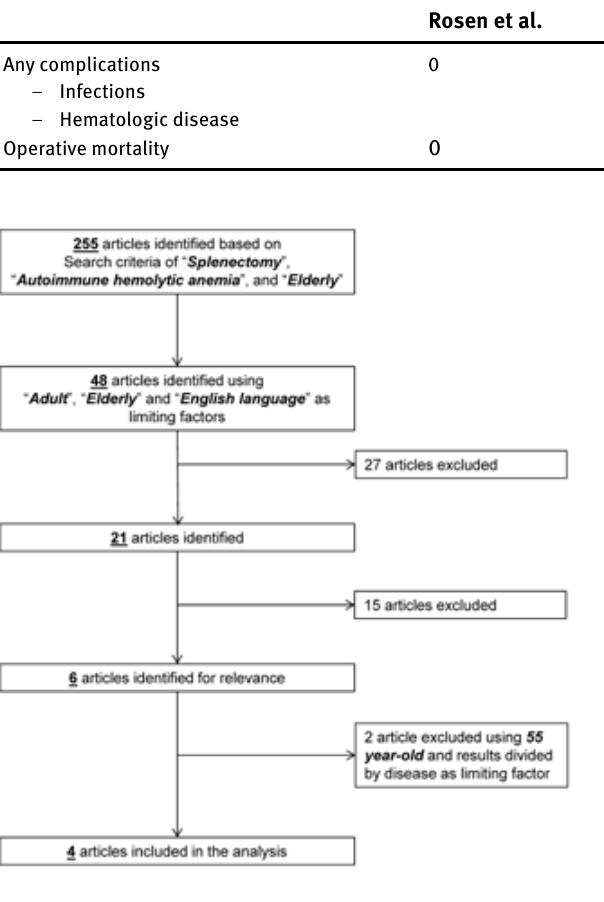
Figure 1: Flow diagram of search strategy